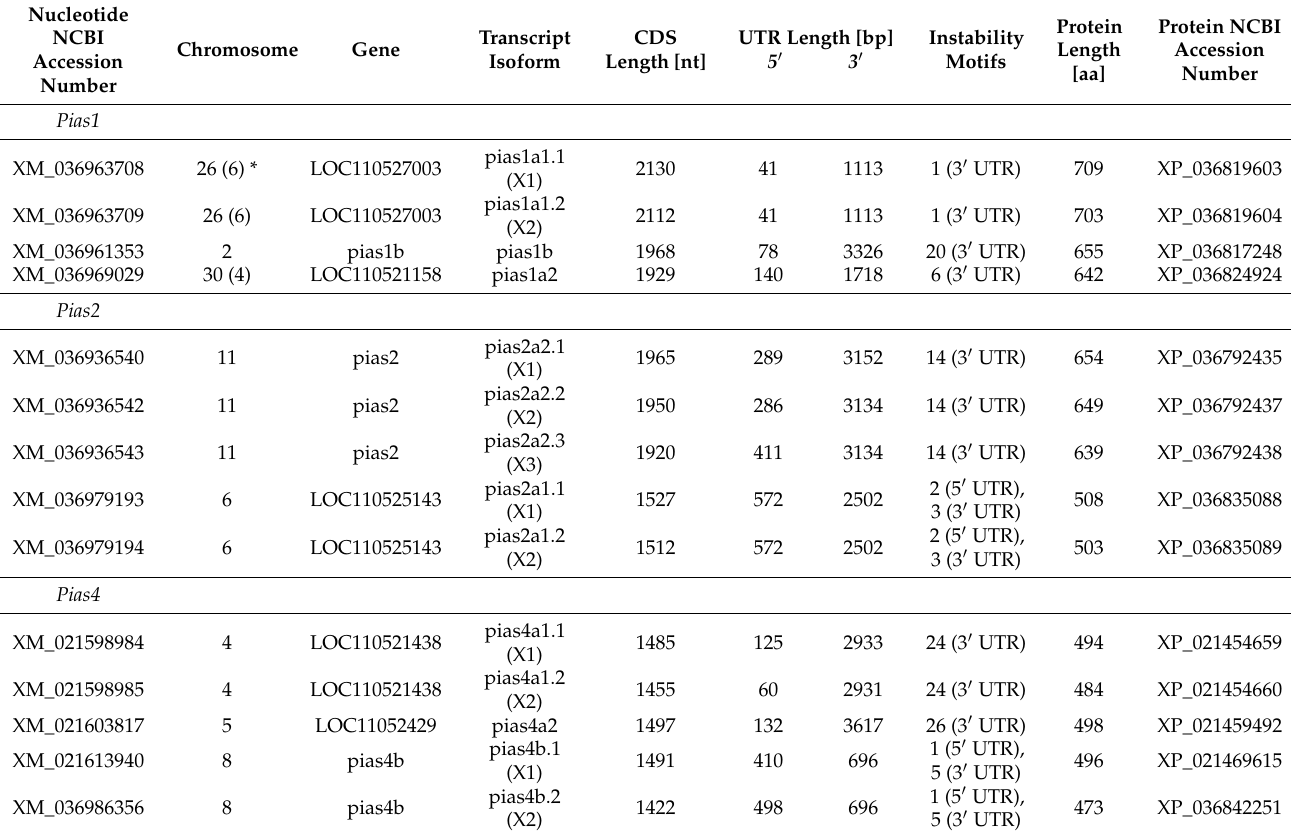
Table 1. Pias sequences identified in rainbow